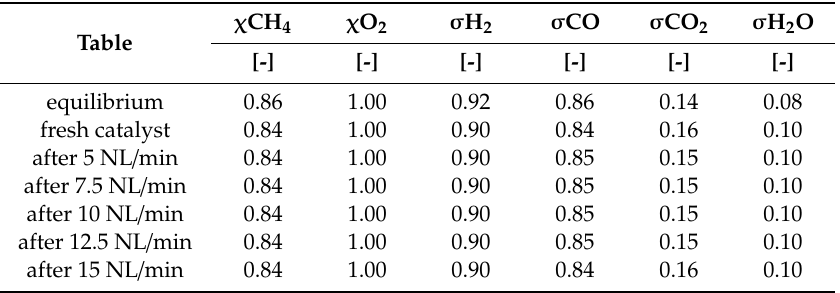
Table 1. Methane CPO: reactants conversion and products selectivity.